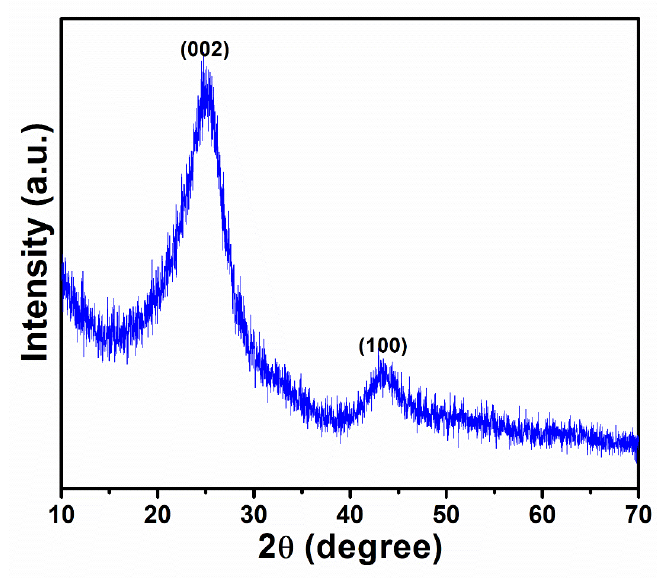
Figure 3. XRD patterns of MWCNTs grown using PECVD method.